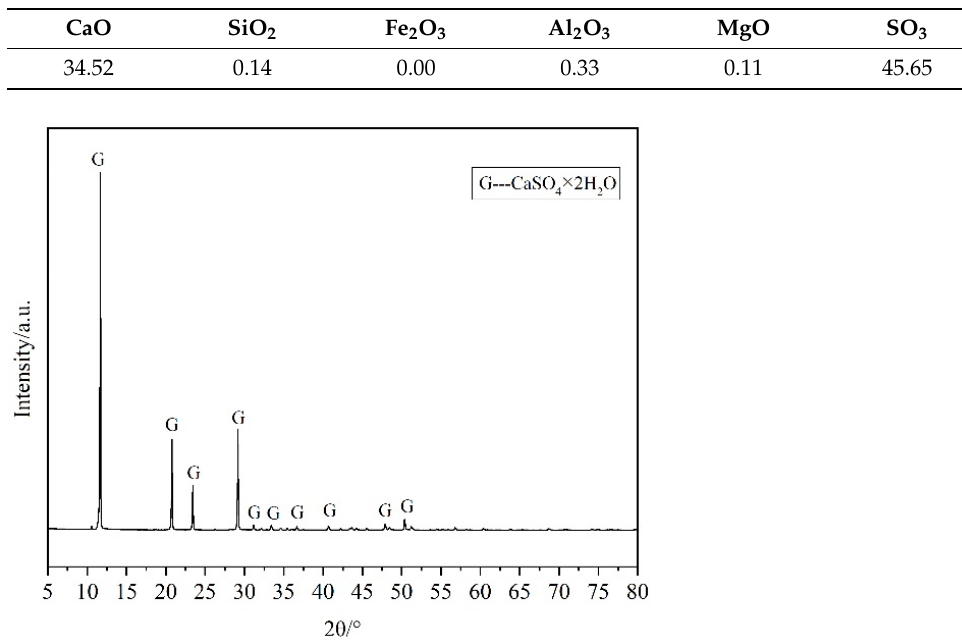
Table 2. Chemical composition of gypsum/wt%.